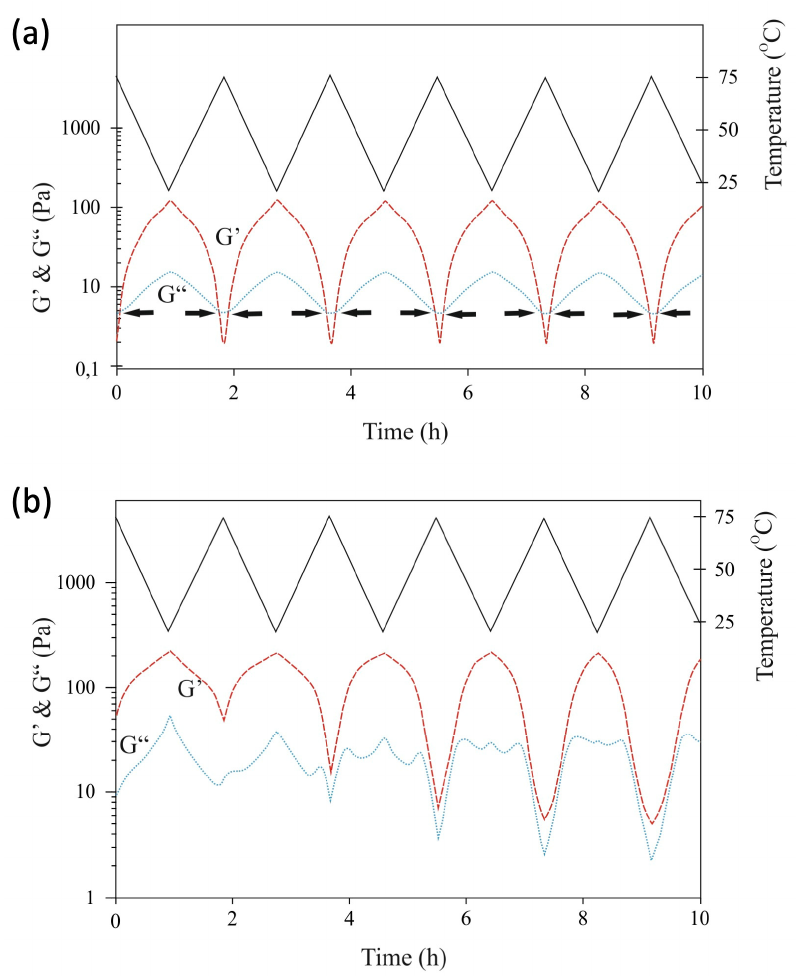
Figure 4. Temperature-dependent storage (G ′ ) and loss (G ″ ) moduli of sc- I ( a ) and sc- II ( b ) hydrogels upon heating to 75 °C and subsequent cooling to 25 °C (solid grey line). Arrows in ( a ) indicate the sol-gel and gel-sol transitions. In both cases the solutions were prepared in PBS, pH = 7.4. Concentrations: sc- I, 10 wt.%; sc- II , 20 wt.%.